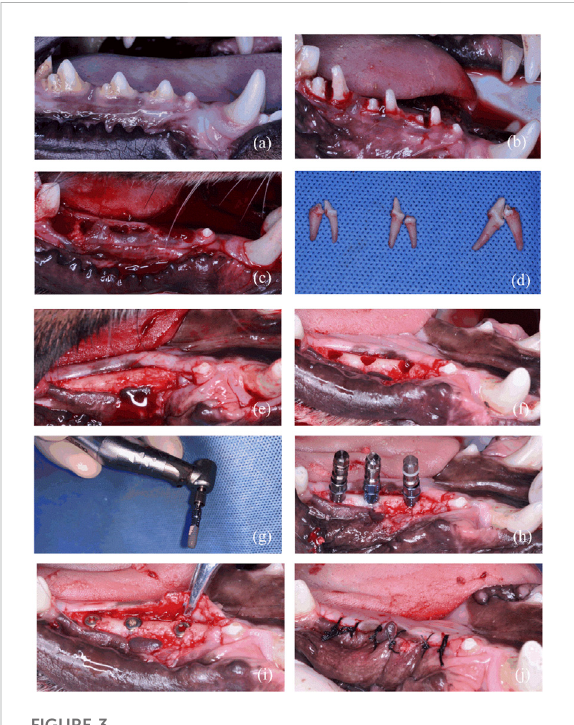
FIGURE 3 Surgical stages of in vivo experiment. (A) Preoperative photo. (B) Teeth hemisection prior to extraction. (C) Wound after extractions. (D) Isolated teeth. (E) Flap after 3-month healing of extractions. (F) Planting nest preparation. (G) Hydrophilic effect of implant treated with NTAP. (H) Implant placement. (I) Screw on the cover screw. (J) Suture after implant